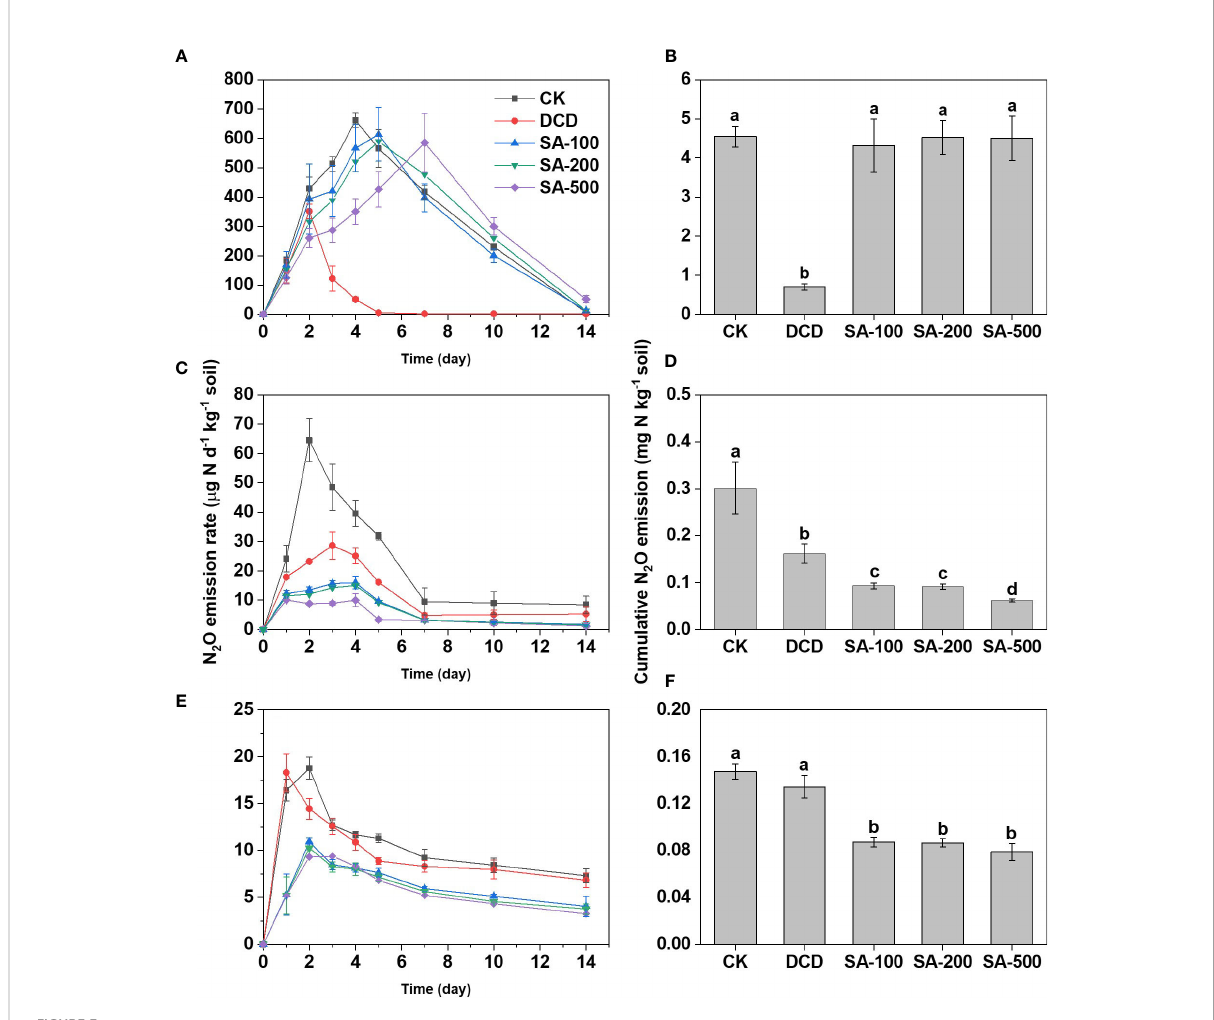
FIGURE 3 The dynamic change of N 2 O fl ux and cumulative emissions in calcareous soil (A, B) , paddy soil (C, D) , and red soil (E, F) during the 14-d incubation. Values are means ± SE (n=3). Different letters indicate signi fi cant differences at P < 0.05 (LSD test) among